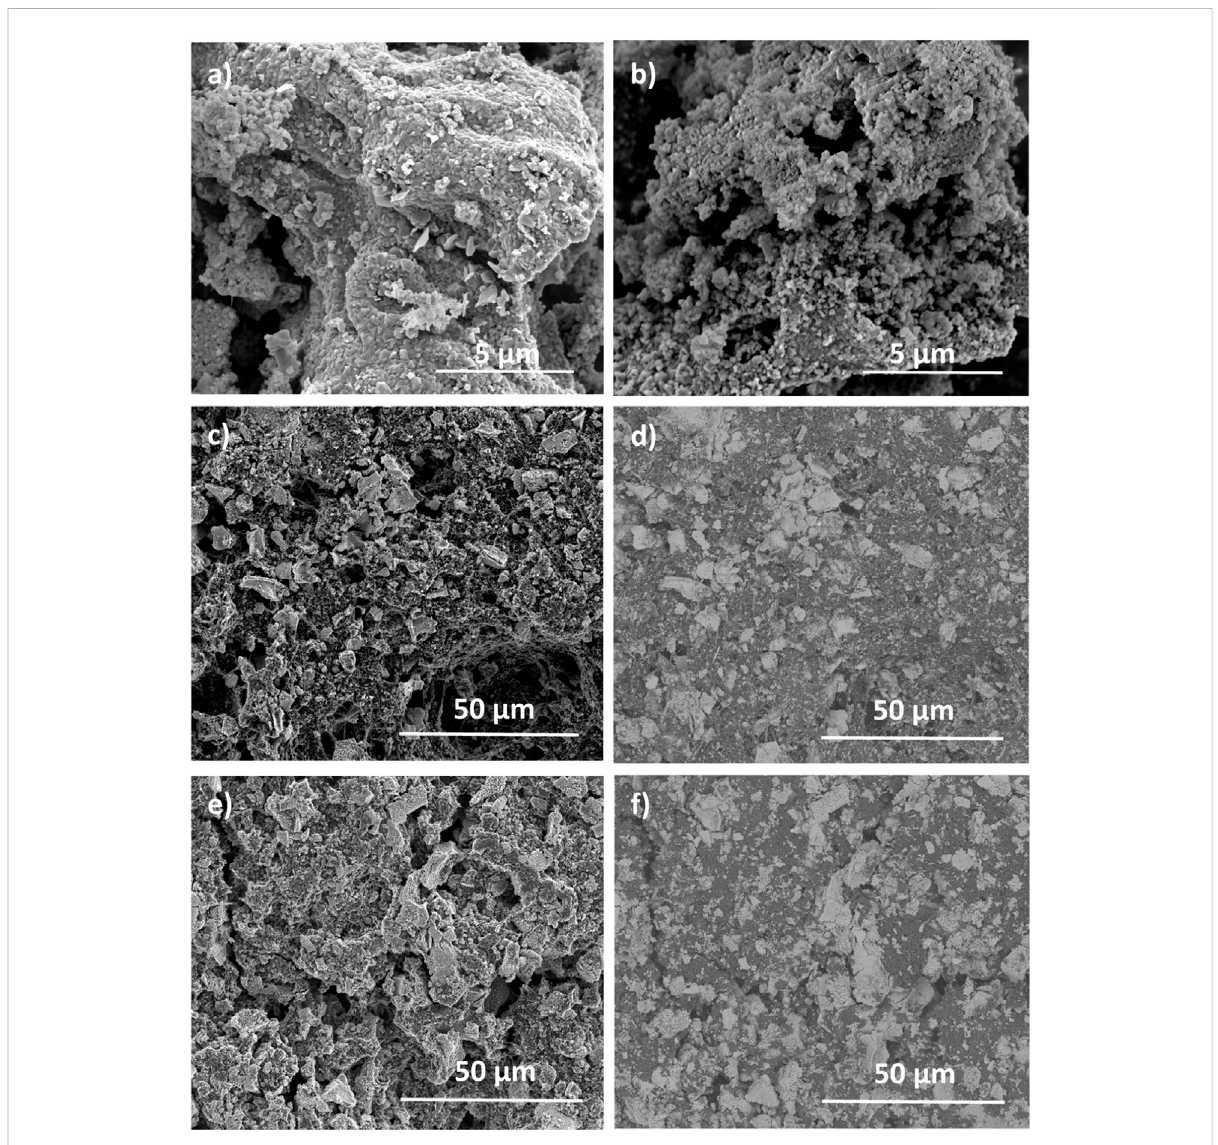
FIGURE 3 SEM images of P3-NMM (A) freshly prepared (B) powder immersed in water and then dried at 80 ° C to remove excess water before drying at 120 ° C under vacuum; (C) secondary electron image of a P3-NNM cathode prepared using PVDF and (D) corresponding BSE image; (E)